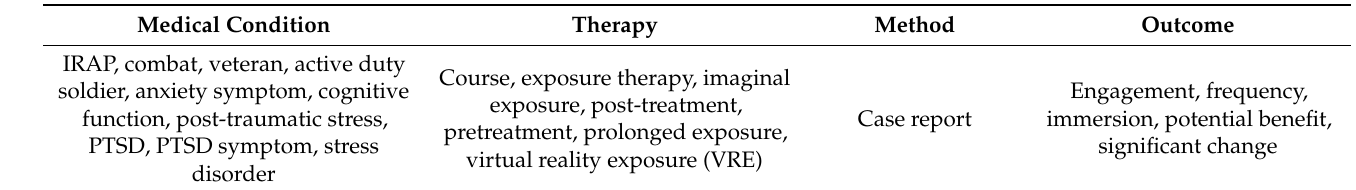
Table 3. Categorized terms associated with post-traumatic stress disorder from Figure 6 (devised by the